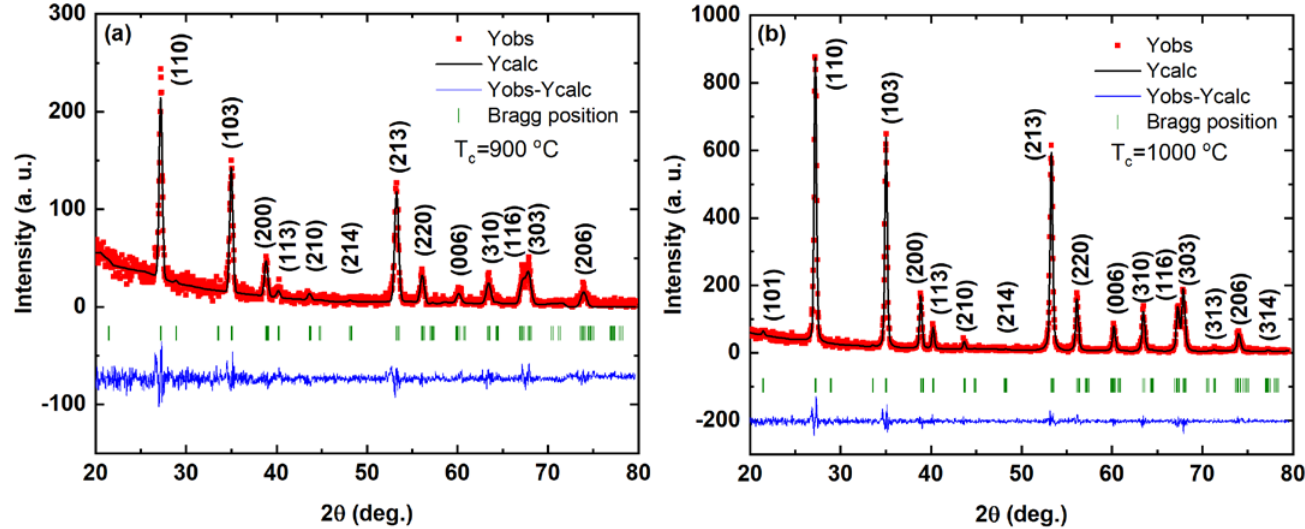
Figure 1. The observed (red squares), calculated (solid line), and difference X-ray powder diffraction patterns obtained from a Rietveld refinement for the FeSbO 4 powder calcinated at: ( a ) 900 °C and ( b ) 1000 °C. The green vertical ticks indicate the calculated Bragg peaks allowed by the space group P 4 2 / mnm (#136).